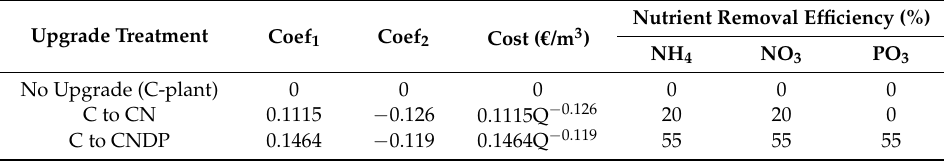
Nutrient Removal Efficiency (%) NH 4 NO 3 PO 3